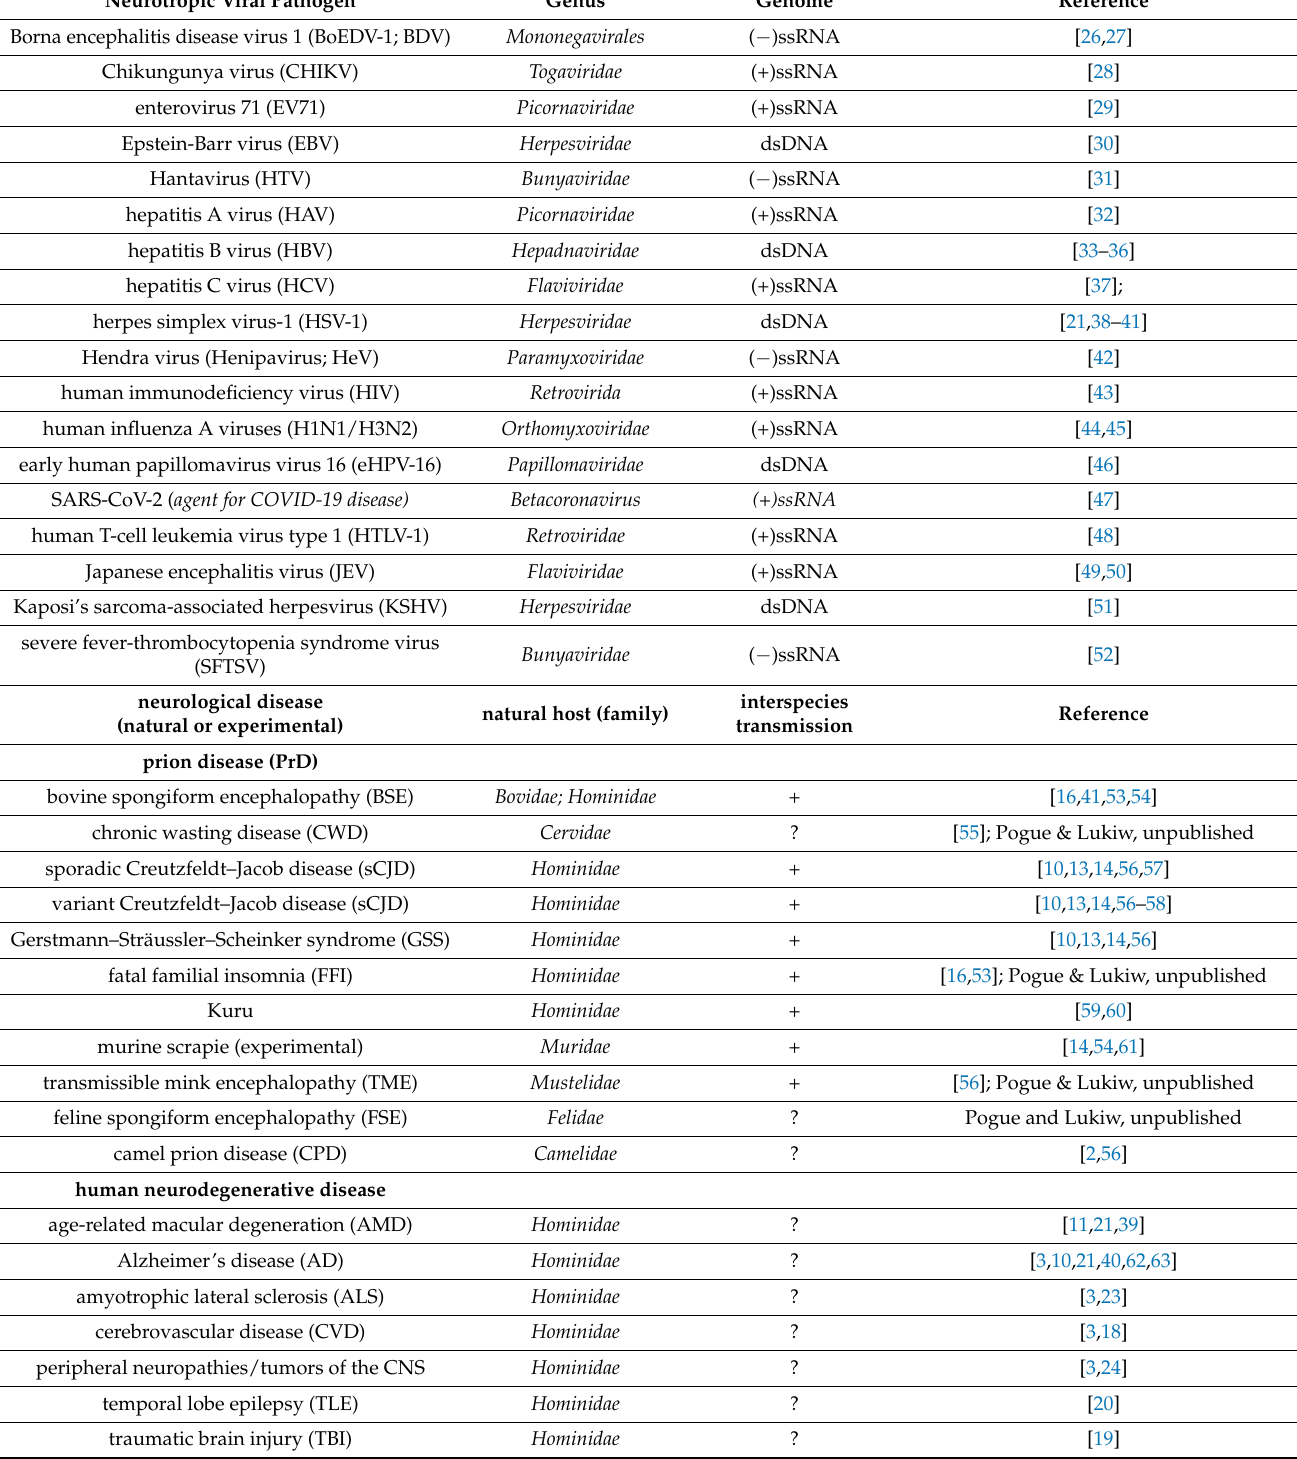
Table 1. Progressive, age-related neurological disorders in which miRNA-146a-5p is significantly upregulated in brain or CNS tissues; all neurotropic viruses indicated ultimately affect human brain or CNS function; ( − )ssRNA = negative single-stranded RNA; (+)ssRNA = positive single-stranded RNA; dsDNA = double-stranded DNA genomes; prions contain no detectable nucleic acids [25]; natural hosts for prion infection are indicated; ‘interspecies transmission’ indicates disease transmissibility in experimental laboratory animals; there may be other neurotropic viruses or PrDs that involve miRNA-146a-5p remaining to be discovered; all neurotropic virus and prion diseases are alphabetically ordered; see also manuscript